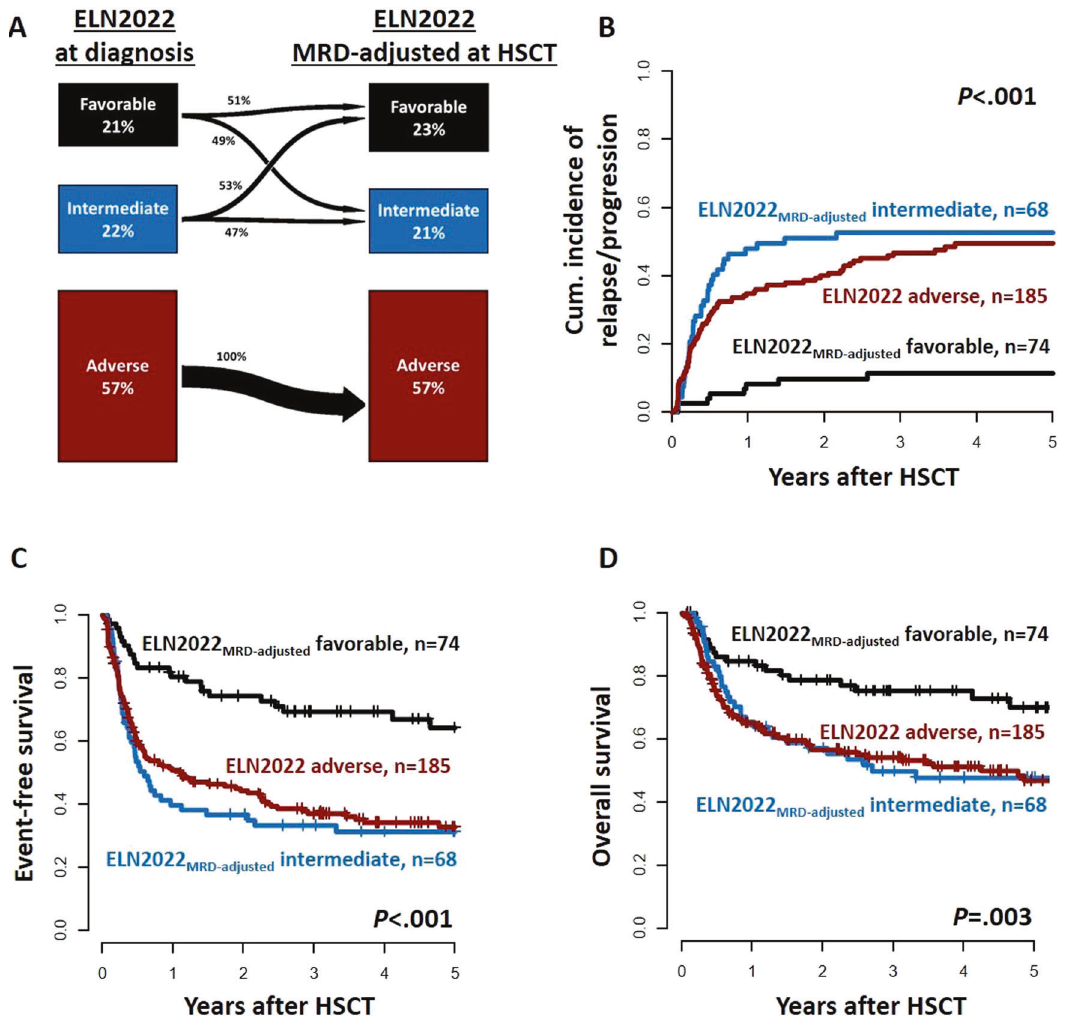
Fig. 4 Outcomes according to the MRD-adjusted ELN2022 risk groups (favorable: ELN2022 favorable or intermediate + MRD neg at HSCT; intermediate: ELN2022 favorable or intermediate + MRD pos at HSCT, adverse: ELN2022 adverse). A Transition plot for patients ’ distribution from diagnosis to HSCT, B Cumulative incidence of relapse, C Event-free survival, and D Overall survival in patients transplanted in CR/CRi ( n =